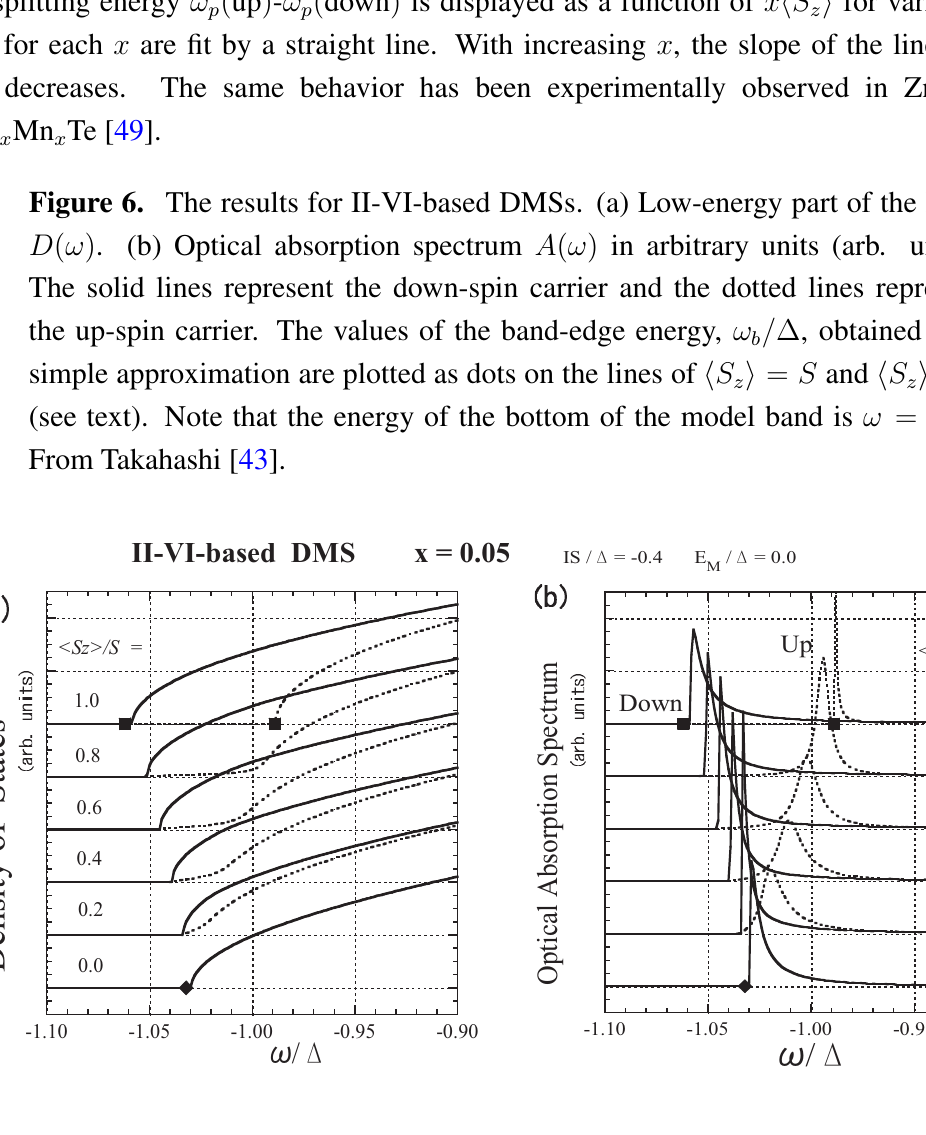
= ∆ , obtained by a b ⟩ = S and ⟨ S ⟩ = 0 z z